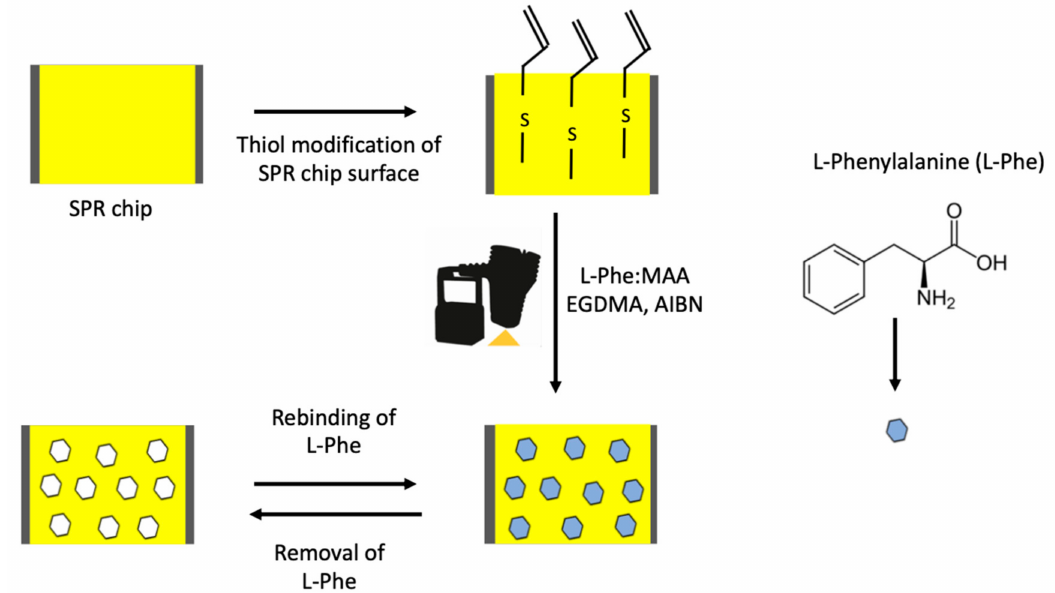
Figure 1. Schematic illustration of the preparation of the L -phenylalanine ( L -Phe) imprinted surface plasmon resonance (SPR)